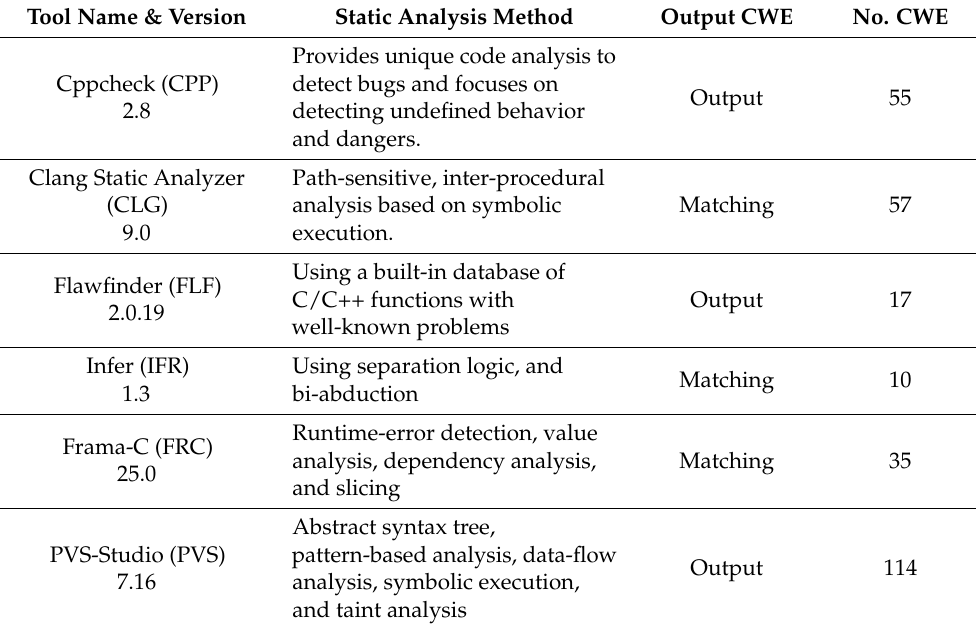
Table 2. Overview of selected multiple static analysis